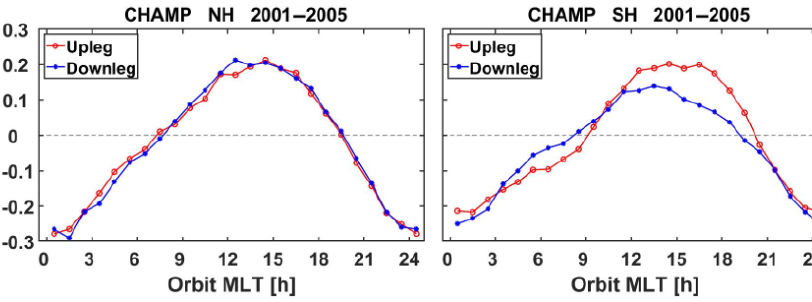
Figure 2. Local time dependence of auroral net currents separately for results from upleg and downleg passes. Best matches, shown here, are obtained when the contributions from the vertical paths B–C and H–E are neglected.